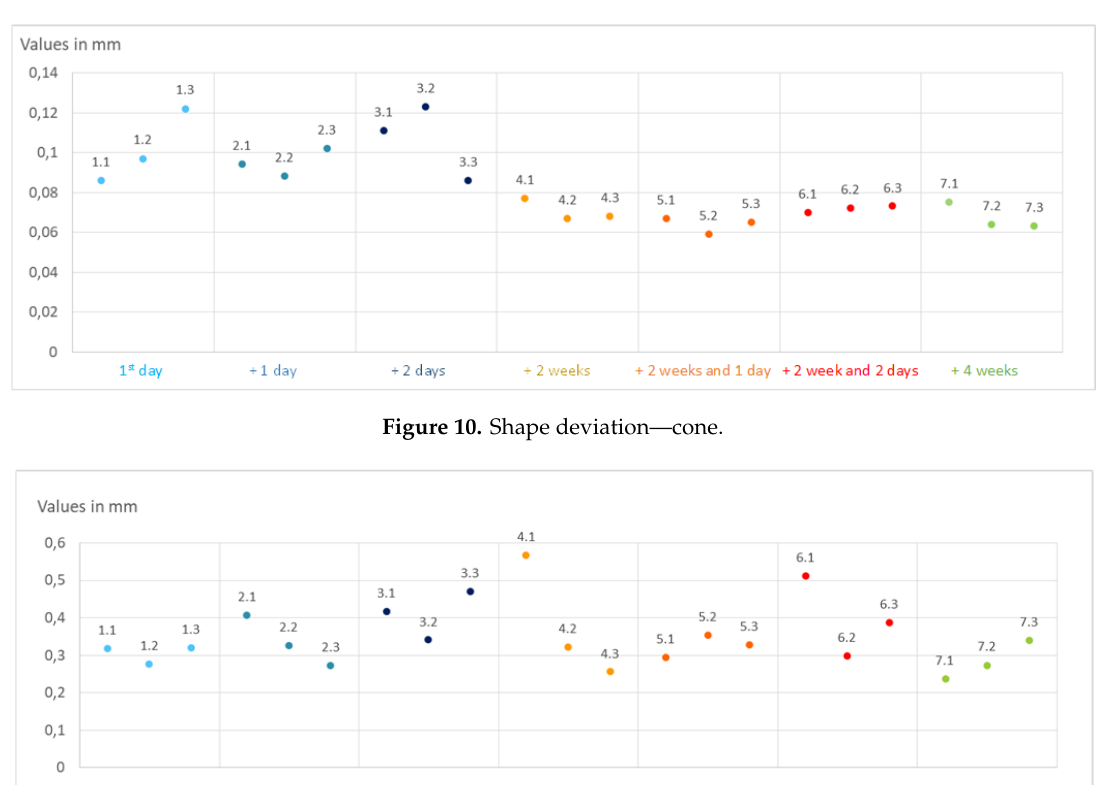
Figure 11. Shape deviation—cylinder.